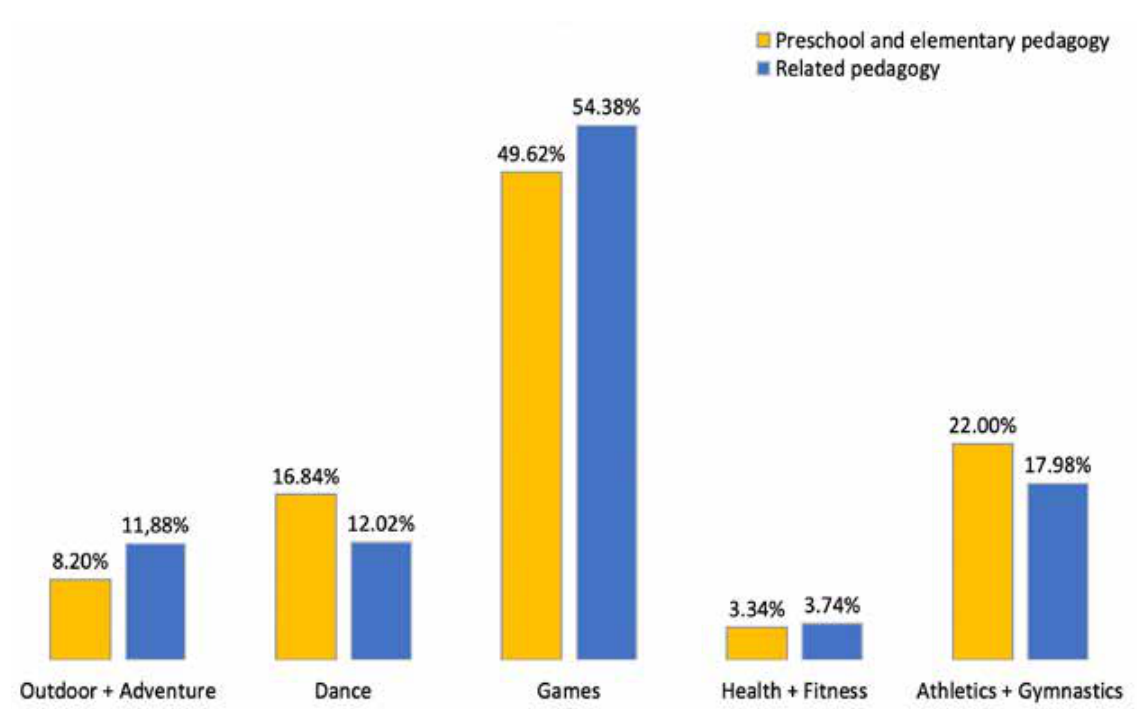
Figure 1. Teachers’ preferences of teaching primary physical education